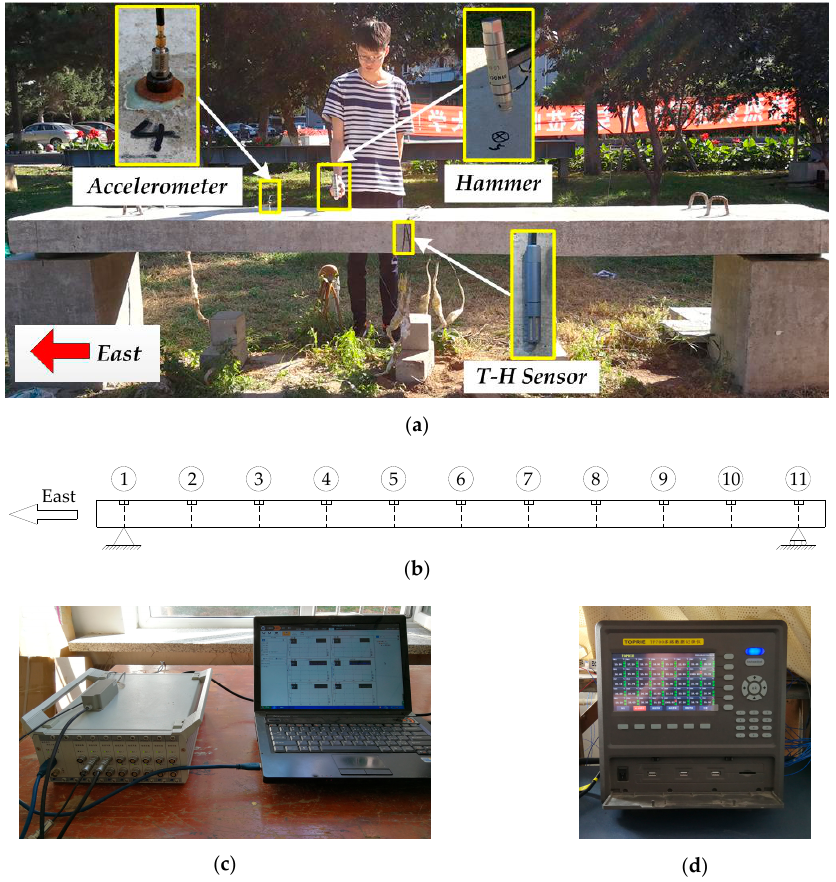
Figure 6. Structural health monitoring system configuration: ( a ) monitoring sensors; ( b ) node numbers; ( c ) DH5922 type dynamic test system; and ( d ) TP700 multichannel data